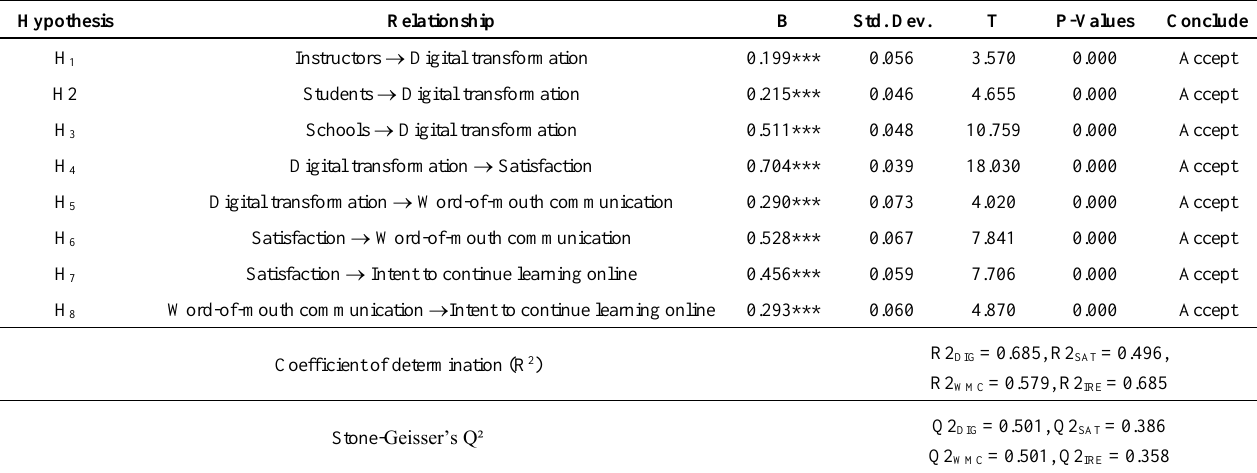
Table 4. Hypothesis test